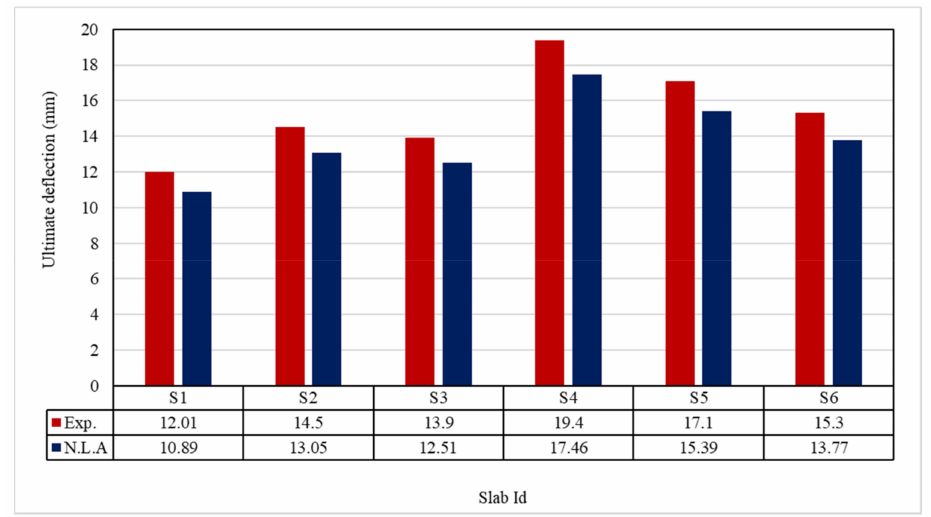
Figure 25. Comparison between Exp. and NLA ultimate